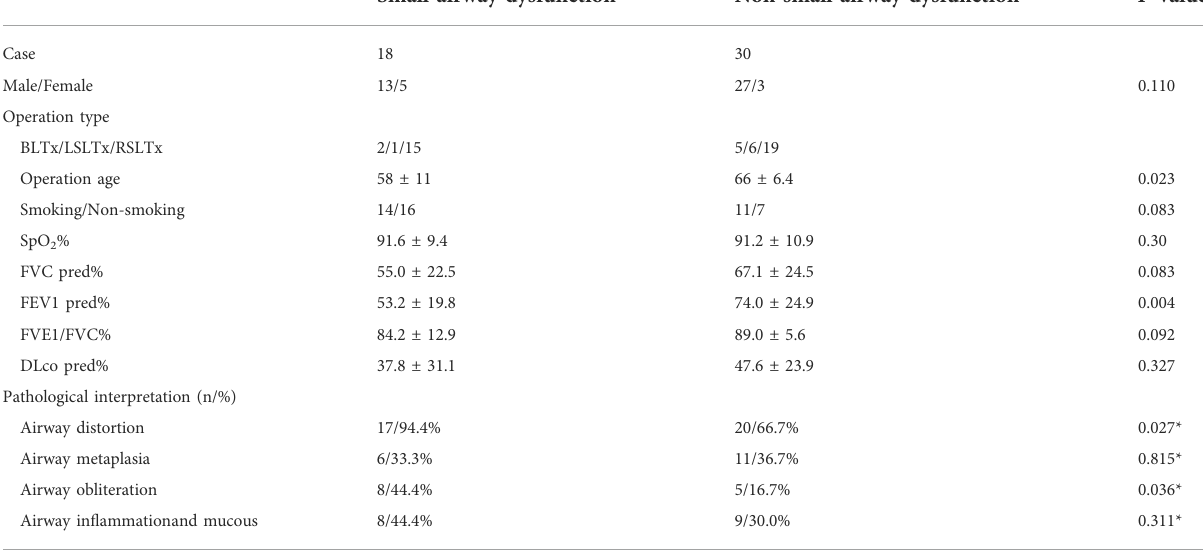
TABLE 3 Characteristics of lung transplantation cases.